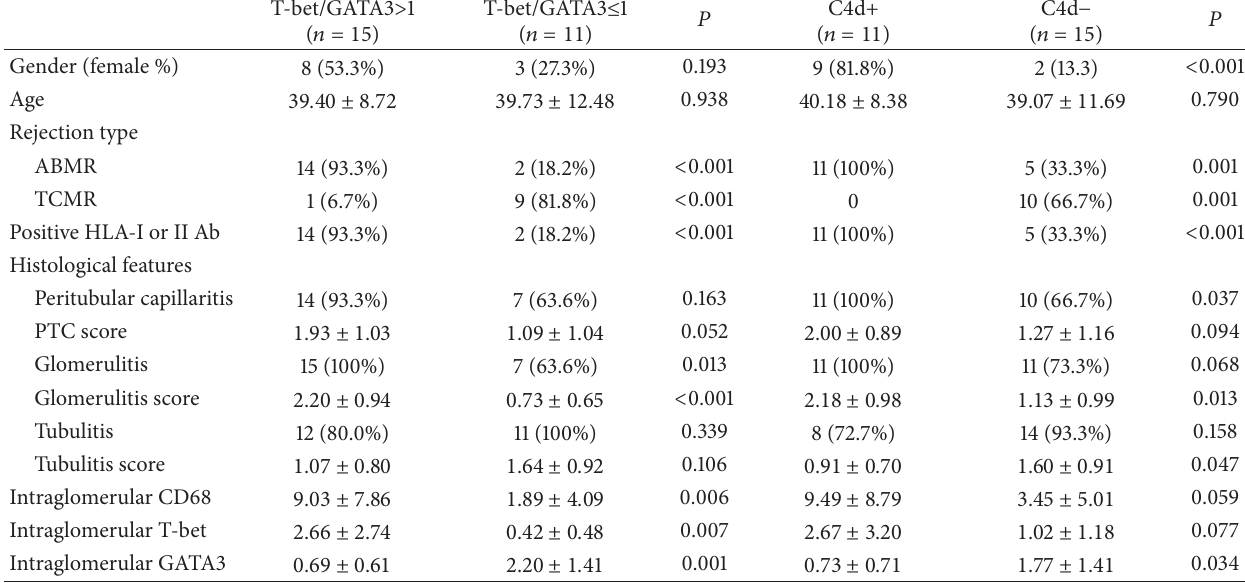
Table 2: Patients’ demography and histologic characters with different T-bet/GATA3 ratios and status of C4d deposition.